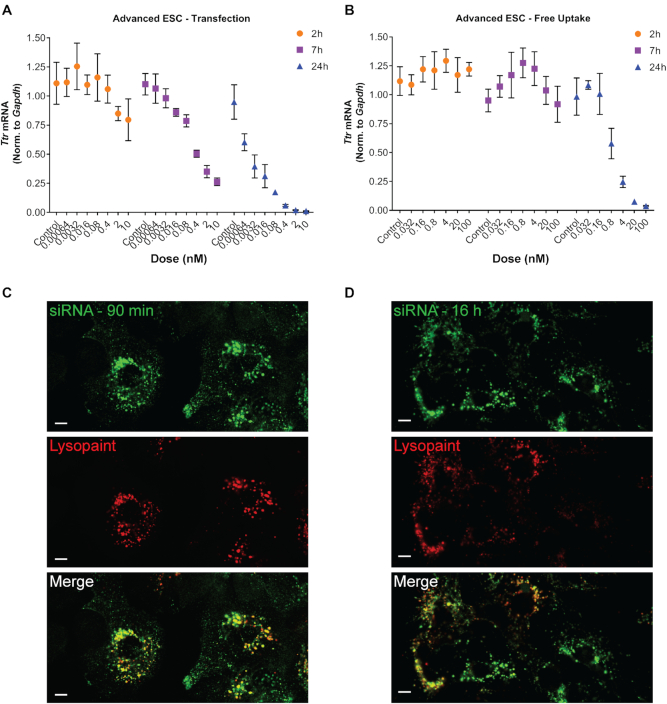
RNAi activity is delayed upon free-uptake of GalNAc–siRNAs. Advanced ESC GalNAc–siRNA-mediated knockdown (siTTR-2) of Ttr mRNA in primary mouse hepatocytes (PMH) following transfection (A) or free uptake (B) relative to Gapdh. A dose response and time course were carried out for all conditions. Similar results were obtained for an ESC GalNAc–siRNA design (siTTR-1, Supplementary Figure S1). Data is represented as mean ± SD, for N = 3. (C, D) An Advanced ESC GalNAc–siRNA labeled with Alexa-488 (siTTR-4, green, 5′ end of the sense strand), was incubated with primary mouse hepatocytes at 10 nM for free uptake delivery. Cells were treated with Lysosome Cytopaint (red) 90 min (C) or 16 hours (D) after siRNA treatment and live-cell images were taken 20 min later. Scale bars are 10 μm.